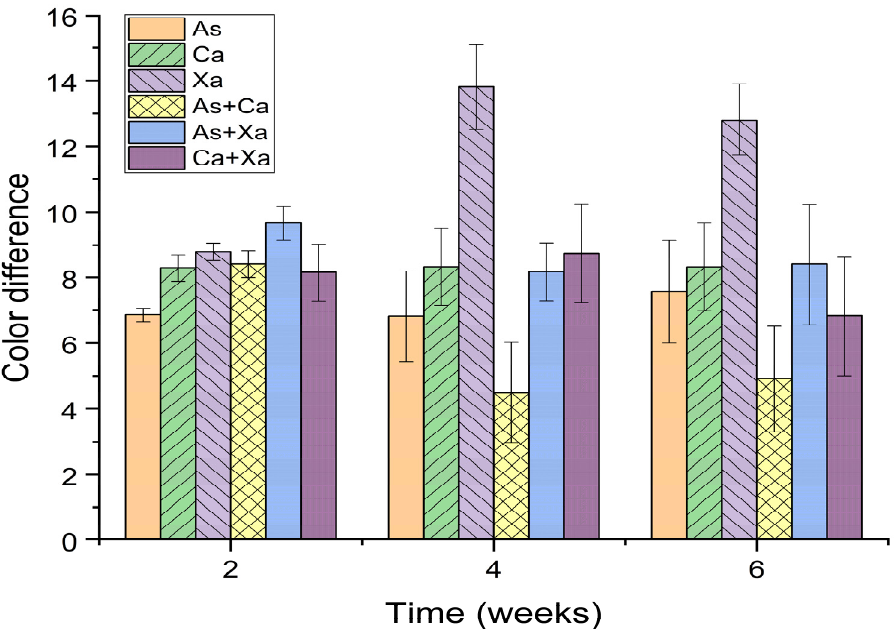
Figure 2. Color performance of bighead catfish fed various dietary pigments at different times of 2, 4, and 6 weeks. Astaxanthin (As), canthaxanthin (Ca), and xanthophyll (Xa).